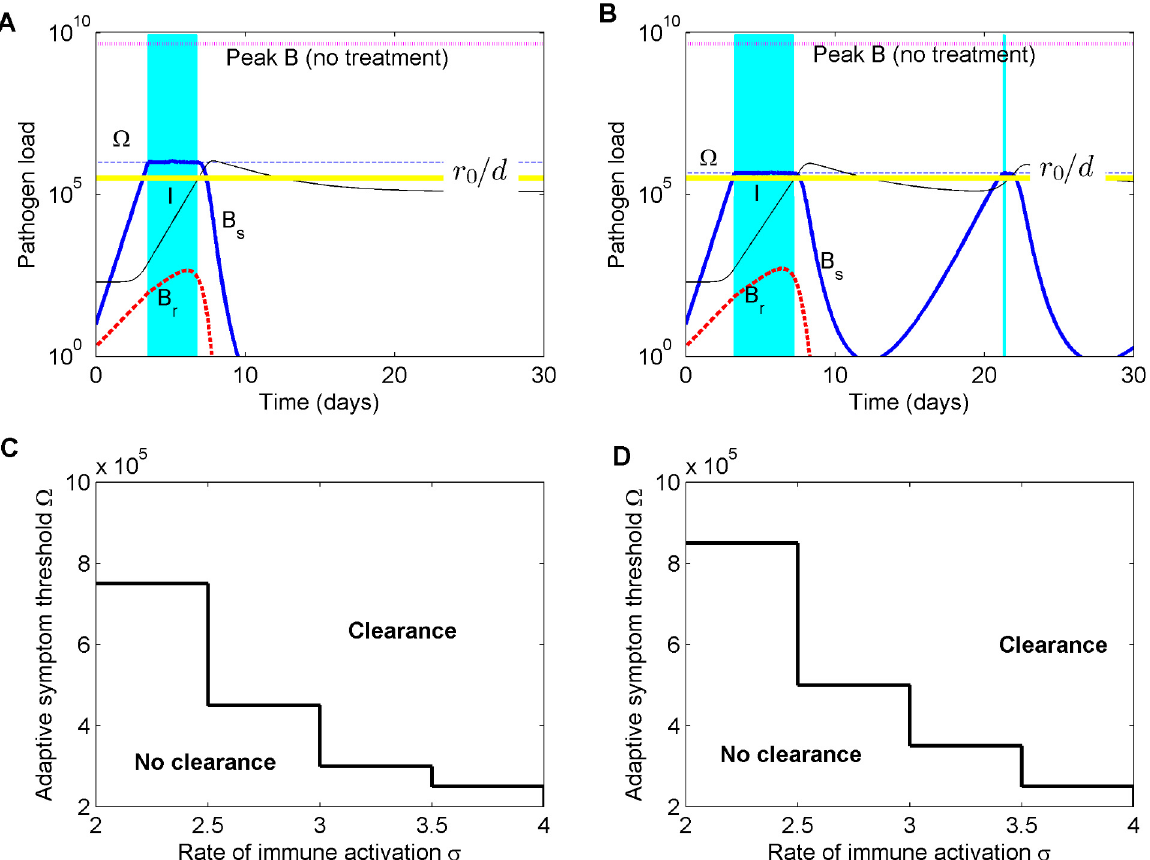
Fig 8. Illustration of adaptive treatment above the immunity threshold ( Ω > k ). A) Clearance dynamics when Ω is sufficiently high ( Ω = 10 k ), i.e. satisfies Eq 22. B) No clearance dynamics, when Ω is too close to k ( Ω = 5.6 k ), and adaptive treatment induces oscillatory dynamics. C) High rate of effector cell conversion into memory f = 0.1. D) Lower rate of conversion into memory f = 0.05. When persistent immunity accumulates faster, the range of symptom thresholds where adaptive treatment works, approaches the host immunity threshold, enabling treatment success at lower pathogen densities. Parameters as in Table 1, with k = 10 5